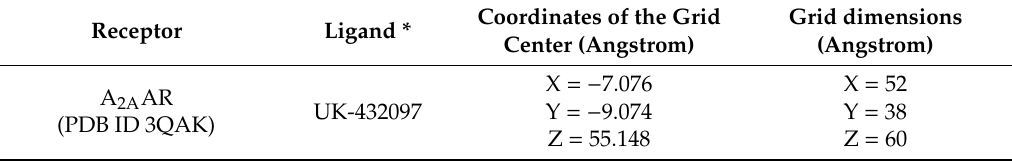
Table 13. Protocols used for the molecular docking study. Coordinates of the Receptor Ligand *